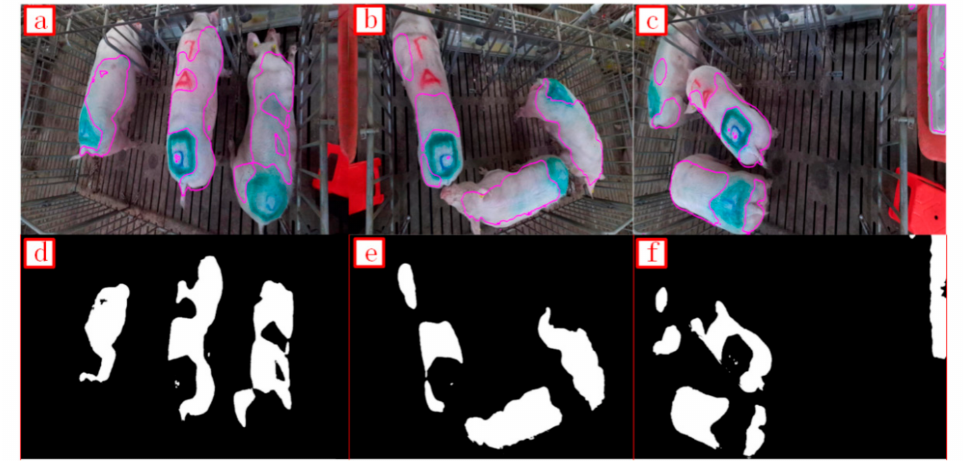
Figure 9. The target detection using UNet-Attention model, ( a ) without adhesion; ( b , c ) with adhesion. The pink outline is the segmentation outcome. The ( d – f ) are the processing binary diagrams of ( a – c ),